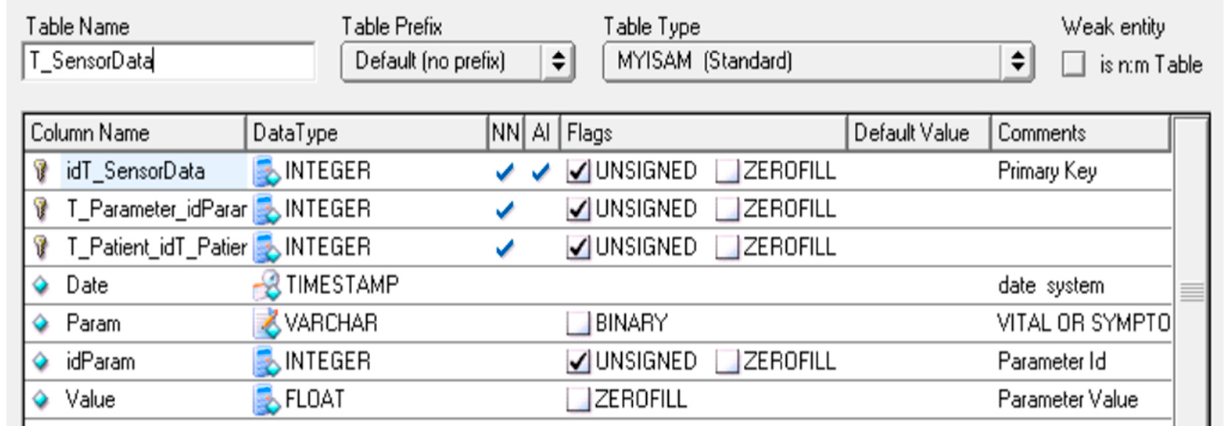
Figure 2. Structure of the T_SensorData table.